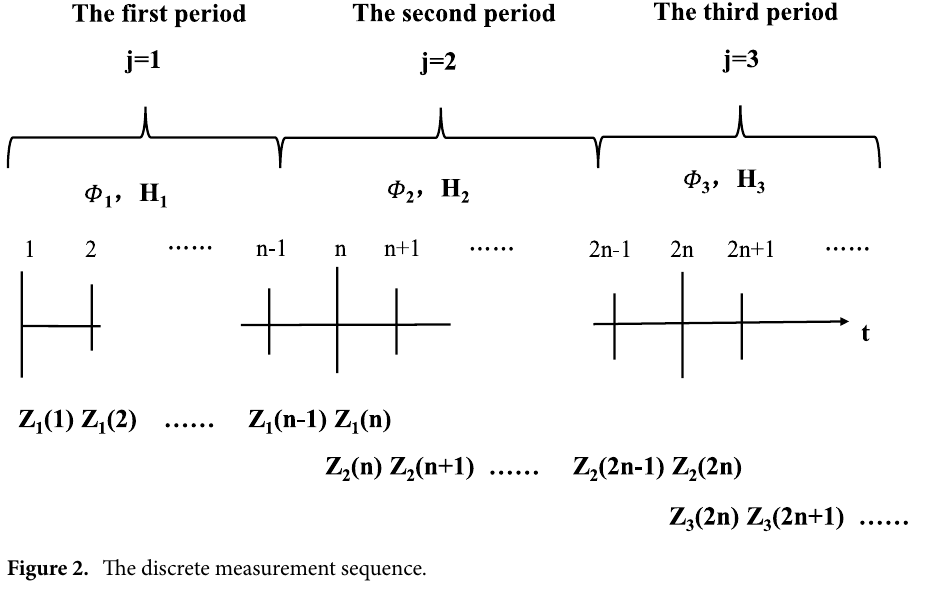
Figure 2. The discrete measurement